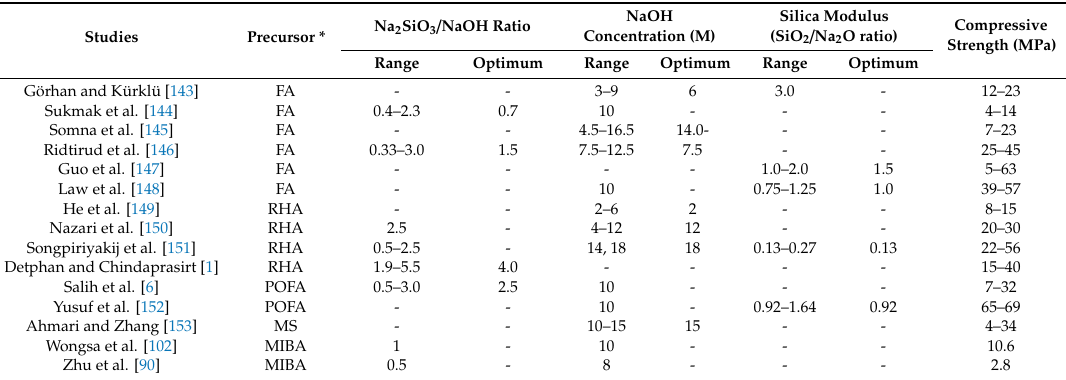
Table 3. Influence of chemical activator on the performance of alkali-activated